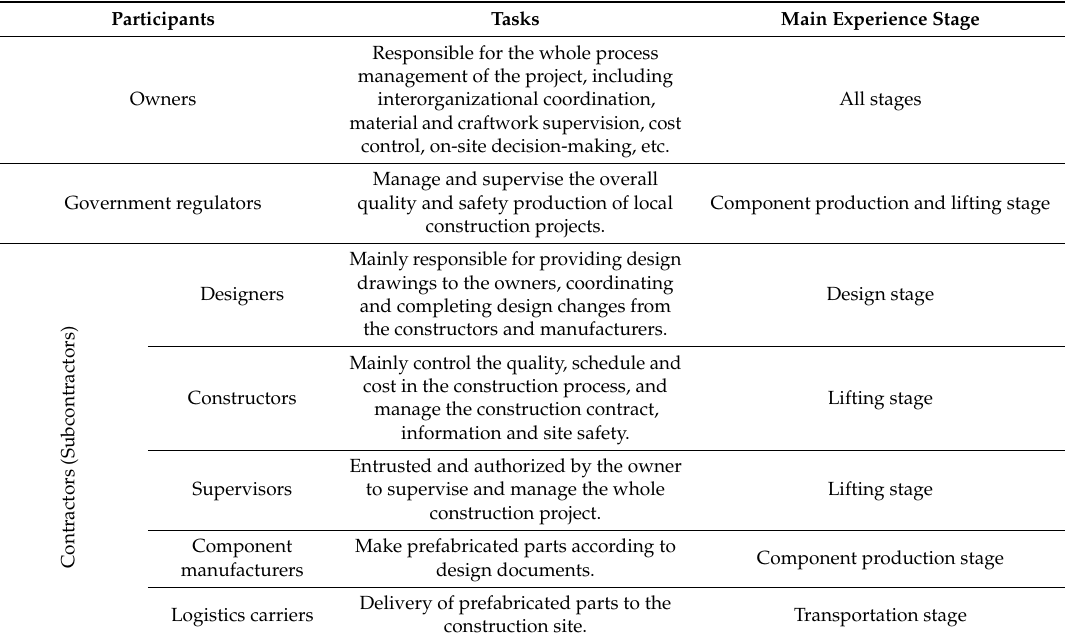
Table 2. The main tasks of